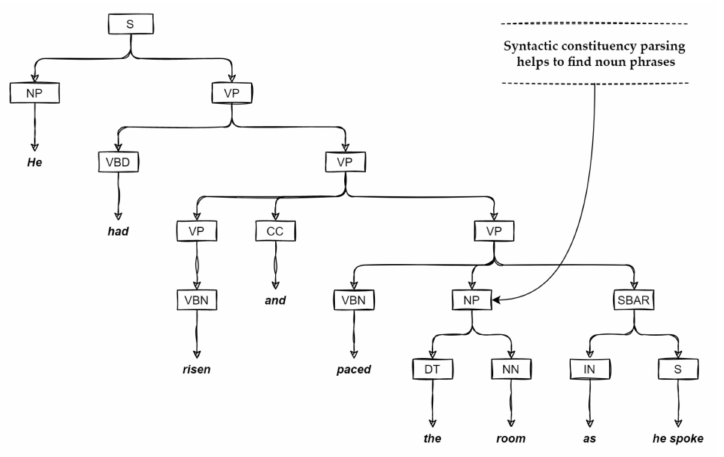
Figure 5. Syntactic constituency parsing results for the sentence “ He had risen and paced the room as he spoke